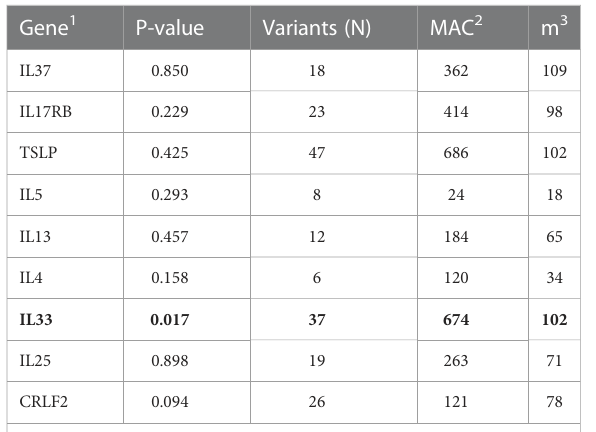
TABLE 3 Gene-based association results using SKAT.